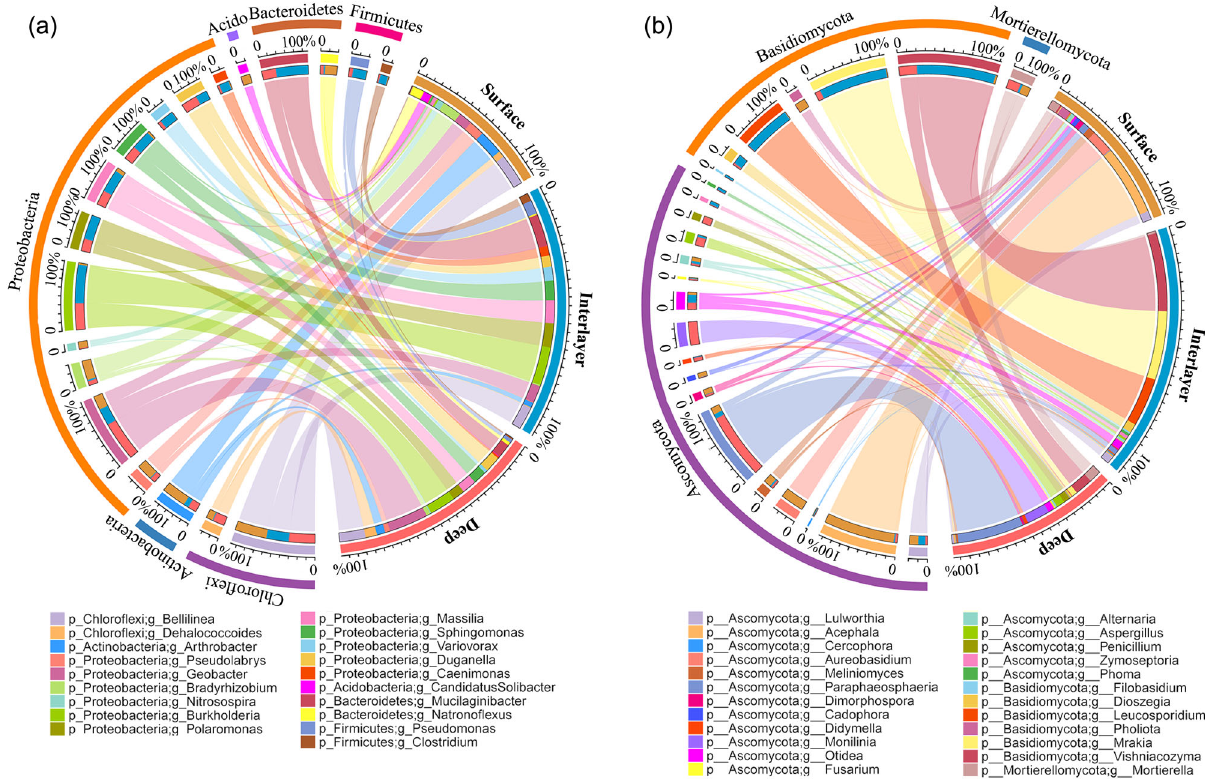
Fig. 4 Comparison of the bacterial and fungal genera abundance in the three water table-dependent soil layers. a bacteria; b fungi (showing relative abundance >0.5%); Acido: Acidobacteri (data and difference of each genus among three layers were shown in Supplementary Tables 2 and